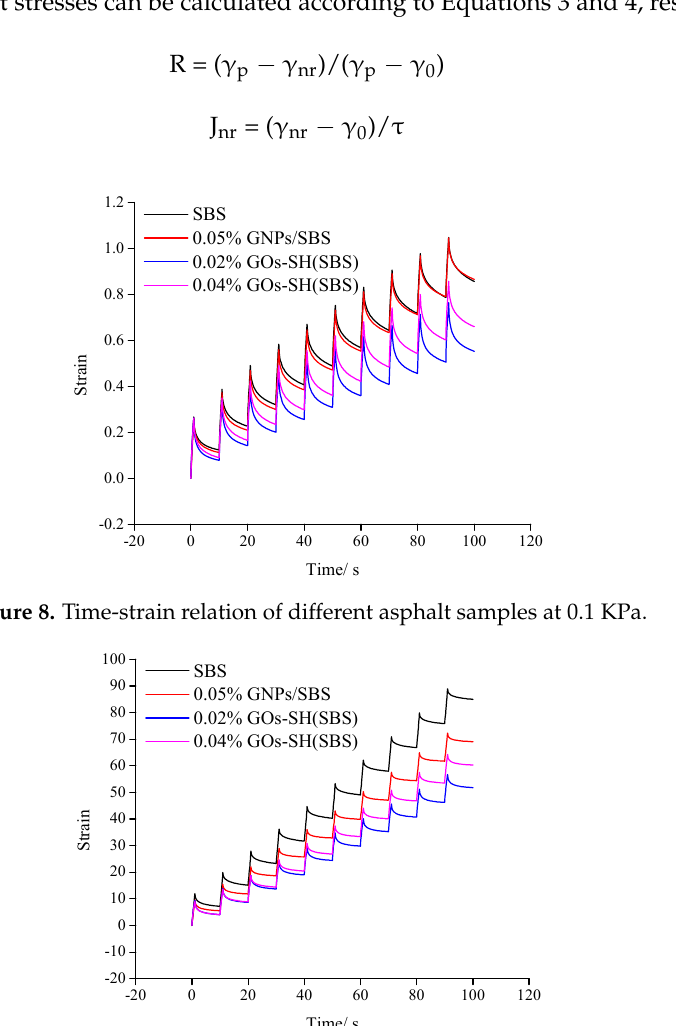
Figure 9. Time-strain relation of different asphalt samples at 3.2 KPa.